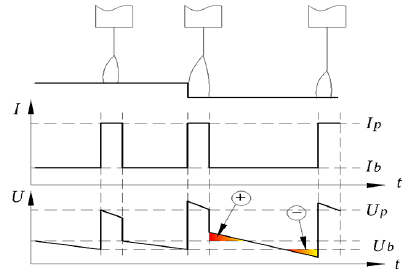
Figure 13. Arc signal characteristics for different torch heights: ( a ) Pulse voltage; ( b ) Pulse frequency; ( c ) Pulse current; ( d ) Base current; ( e ) Base voltage.